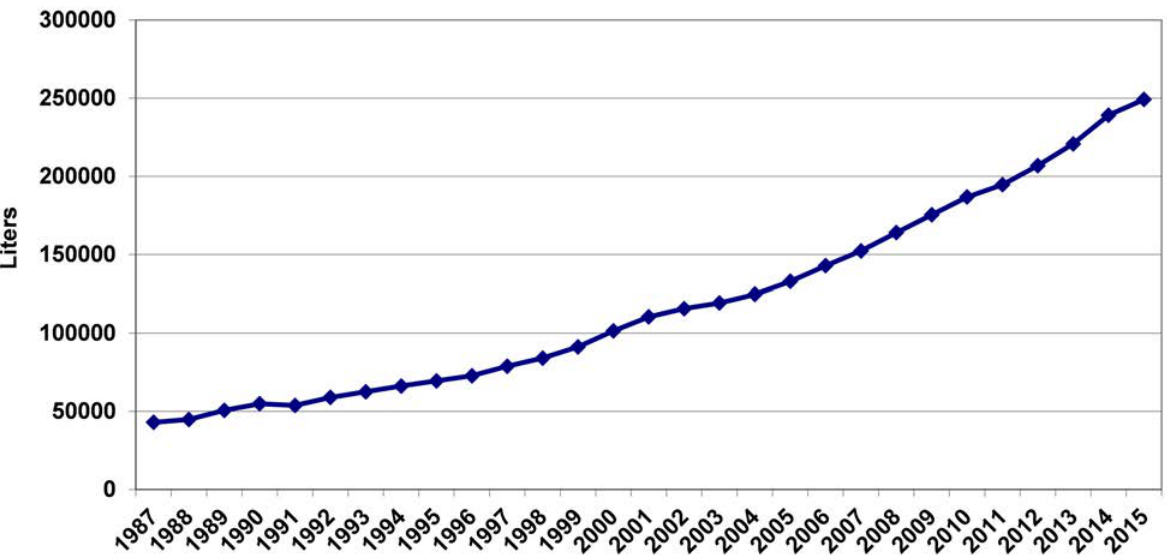
Fig. 5. Average amount of milk delivered to dairies per farm in North Karelia, 1987–2015. Source: Pro Agria